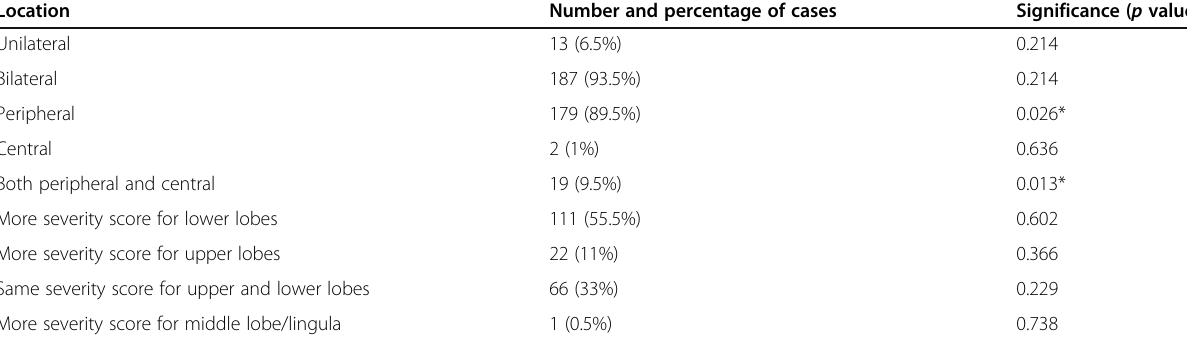
Table 2 Number and percentages of cases according to their distribution and their significance of severity Location